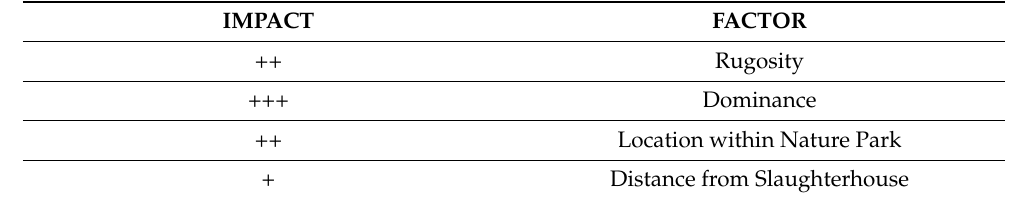
Table 6. Factors that characterize the beef feeding areas oriented toward short supply chains.